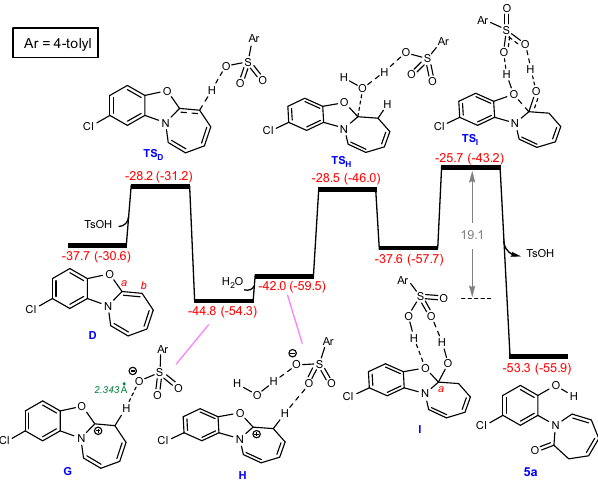
Fig. 8 | Calculated energy pro fi le for TsOH-catalyzed hydrolysis and second ring-openingsteps. Freeenergies(potentialenergies)calculatedattheSMD/M06- 2X/def2-TZVP//SMD/M06-2X/6-31G(d) level oftheory in THF are given in kcal/mol.